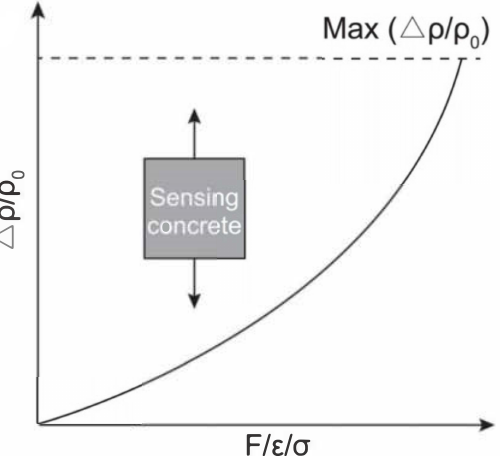
Figure 7. Self-sensing concrete under monotonic tension. Reproduced with permission from [51], Journal of Applied Physics,